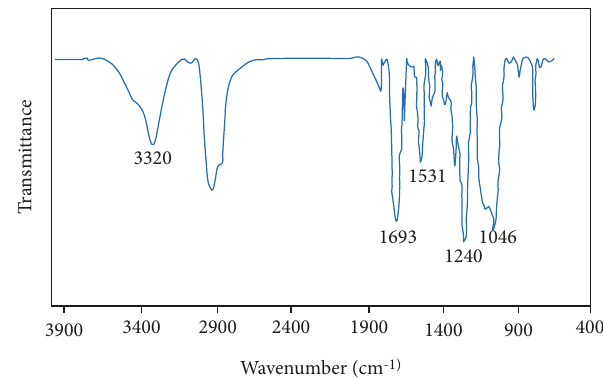
Figure 3: FTIR spectrum of